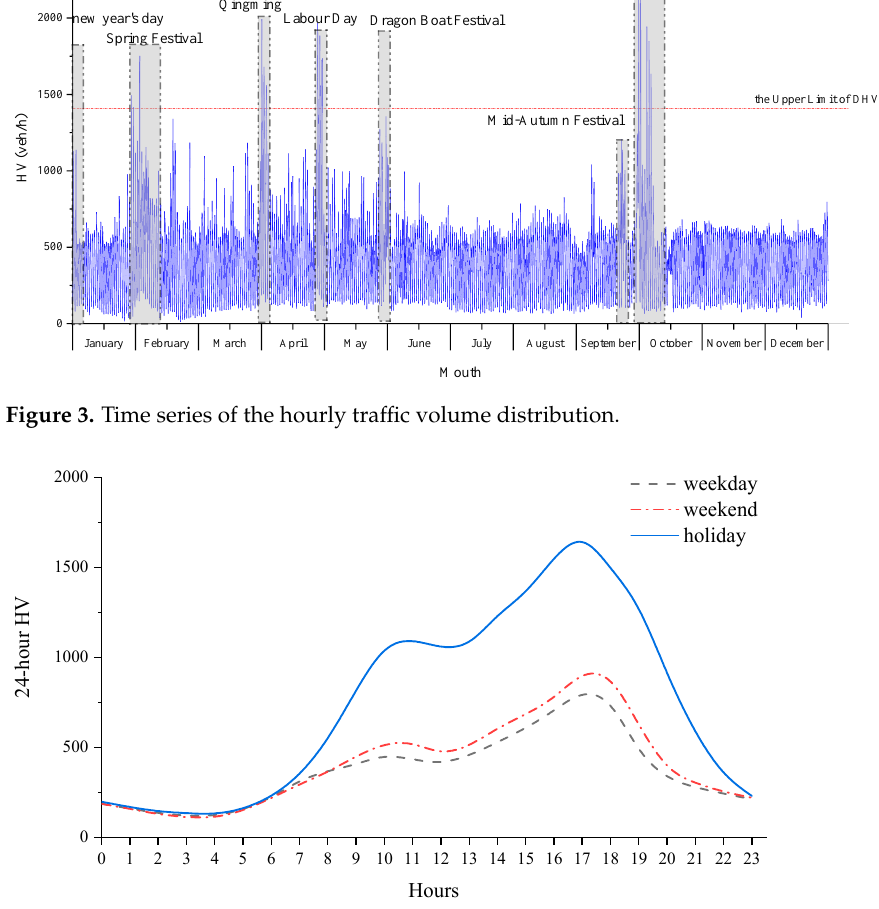
Figure 4. Curves of 24-h traffic volume change on working days, weekends and holidays.